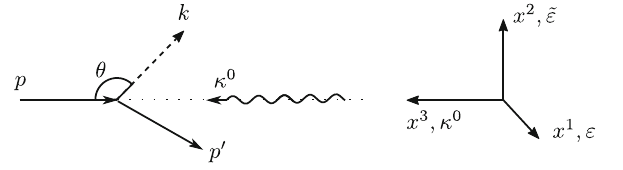
Fig. 1 A schematic diagram of the interaction taking place between the laser background and electron, leading to a scattered electron and